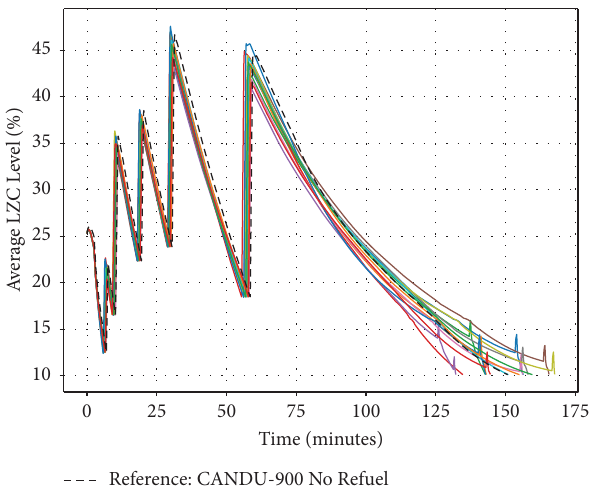
Figure 11: Efect of random burnup snapshots–59% FP